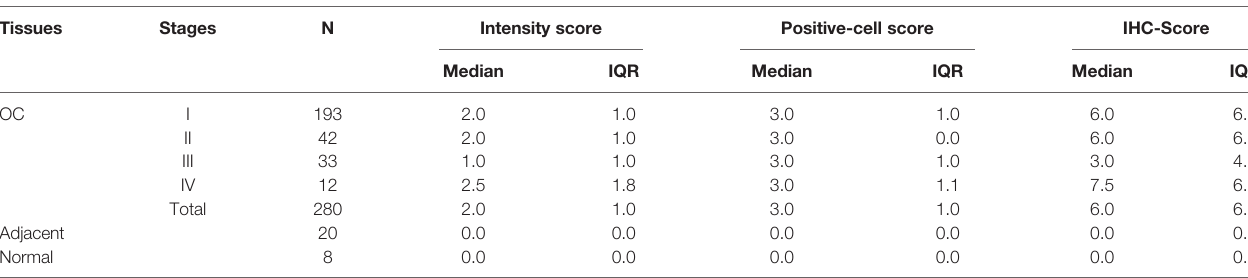
TABLE 2 | Results of IHC analysis.